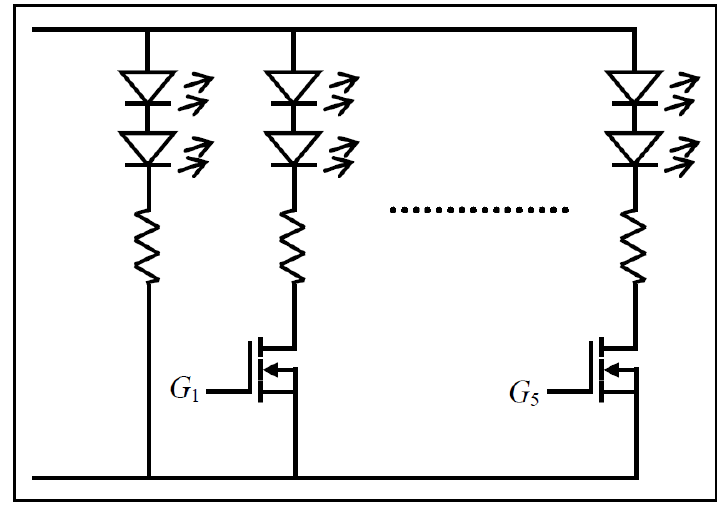
Figure 3. Electronic load.